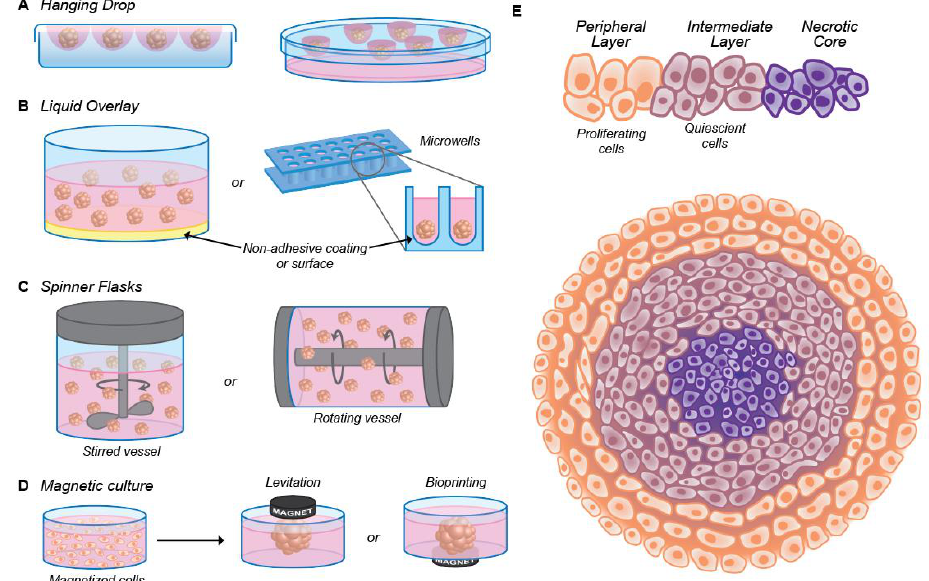
Figure 1. ( A – D ) Illustrative scheme of the methods for the preparation of multicellular tumor spheroid (MCTS):: the hanging drop method, where the cells come together at the bottom of a hanging drop ( A ), the liquid overlay method, where the surface of plates or (conical) wells is coated with a non-adhesive material ( B ), spinner flasks (stirred or rotating vessel), where the cells are kept in suspension ( C ) and magnetic culture, where, after the addition of magnetic particles, the cells are brought together through magnetic forces ( D ). ( E ) Schematic representation of the spheroid physiology depicting the distribution of proliferating (orange, outside layer), quiescent (violet, middle layer) and necrotic cells (purple, at the core). The cellular density is lower in the outside layer.